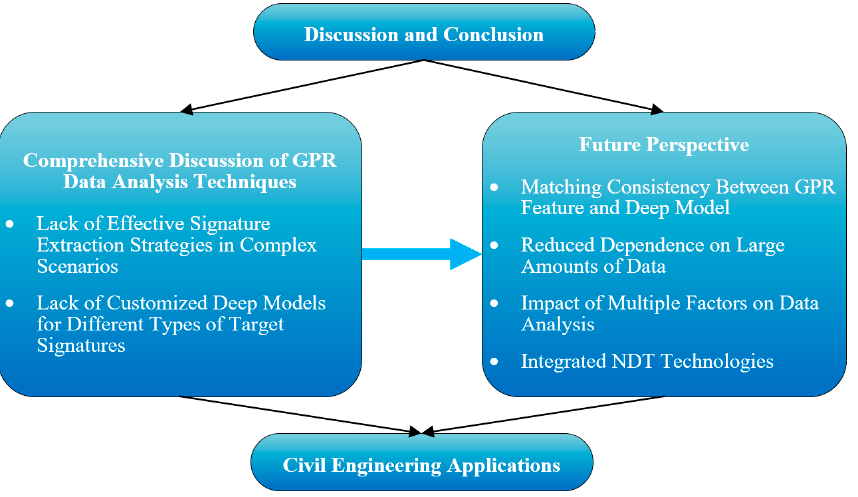
Figure 6. Diagram of discussion and